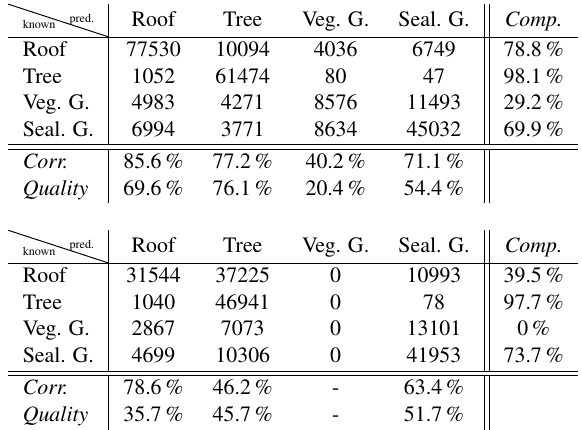
Table 2: Confusion matrices of combined classification results using shape distribution (top) and covariance (bottom) features, ignoring all cases in which an element could not be detected in any of the classes.